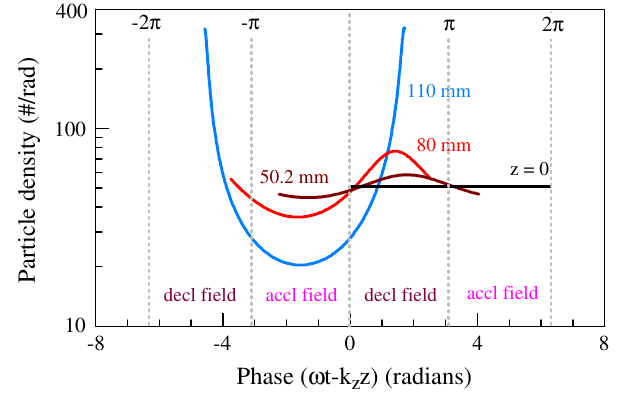
FIG. 7. (Color) Dependence of particle density on phase for axial distances z (cid:3) 0 , 50.2 mm, 80 mm, and 110 mm. It is seen that the density peak value gets larger as the peak drifts left, and two peaks with a phase separation of 2 (cid:3) are formed at z (cid:3) 110 mm .